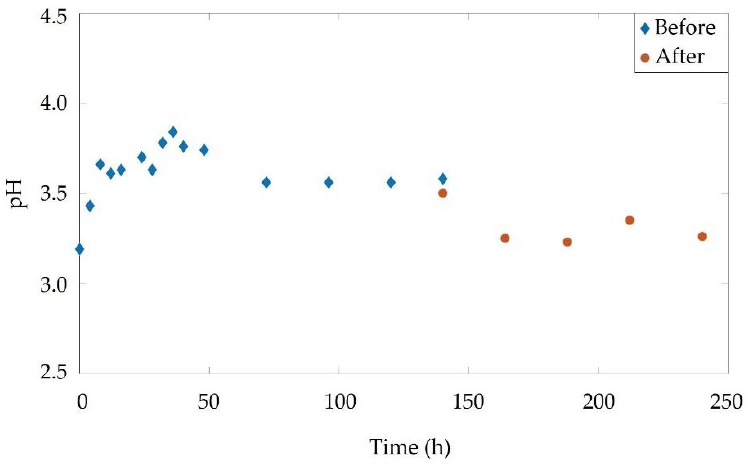
Figure 8. The pH profile of the EM-RS reactional medium before and after the addition of the elec-